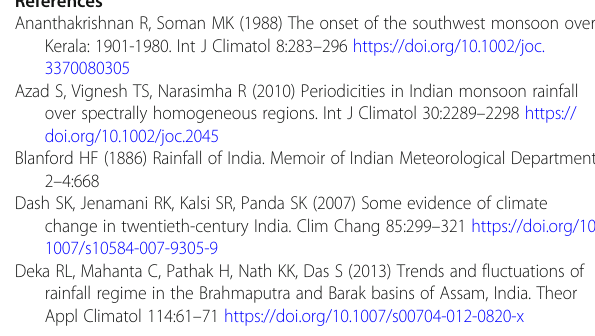
Additional file 1: Correlation coefficients of summer (JJAS) precipitation between the cluster-averaged values and each grid for 1901 – 2013. Correl- ation coefficients of CL1 (a), CL2 (b), CL3 (c), CL4 (d), CL5 (e), CL6 (f), and CL7 (g). Colored grids show the coefficients of correlation with statistical significance levels over 1%. (EPS 1102